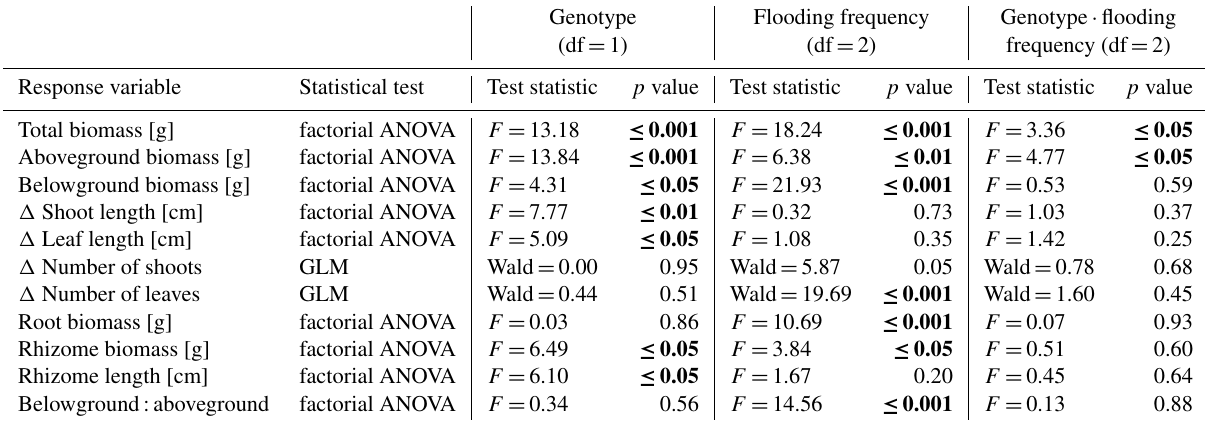
Table 1. Summary statistics of main response variables in the experiment testing for effects of flooding and genotype of Elymus athericus on its biomass and growth. Count variables (number of shoots, number of leaves) are analysed through GLM; all other variables are analysed by a two-way factorial ANOVA. Significant p values are shown in bold letters. Means and standard errors are shown in Figs. 1 and